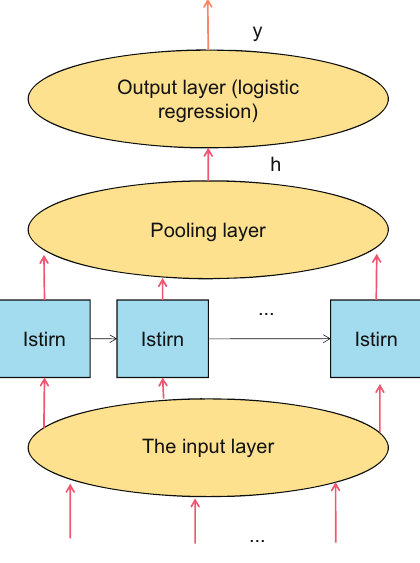
Figure 2: System software defect prediction chart.